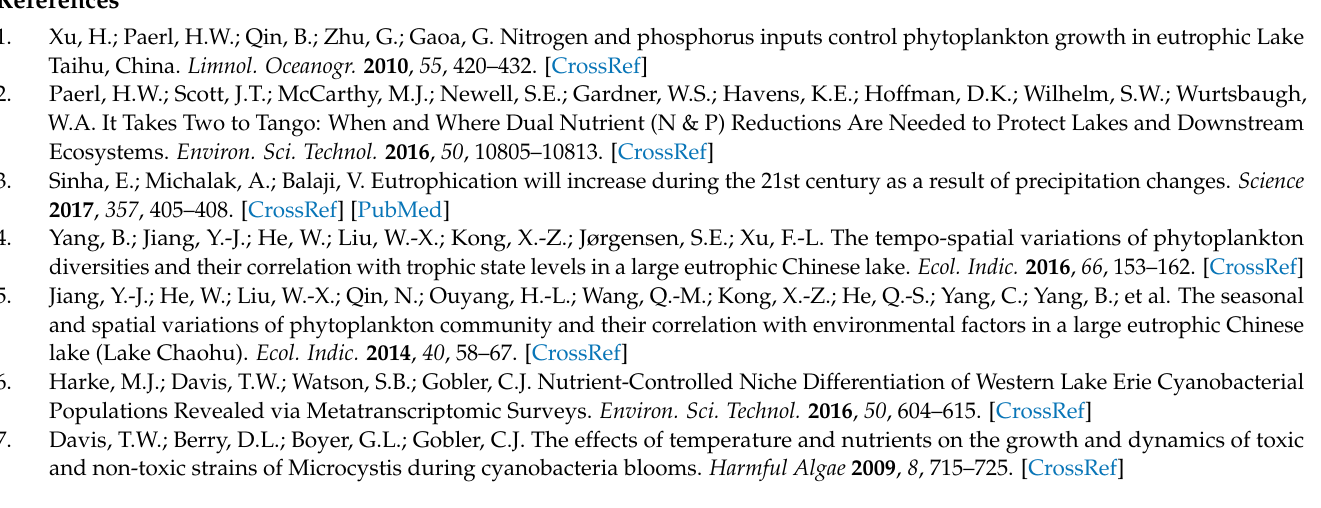
Table S4: The seasonal concentrations of dissolved oxygen in Lake Yangcheng; Figure S1: The locations of sampling sites and the range of pen aquaculture in Lake; Figure S2: The seasonal concentrations of nutrients in each